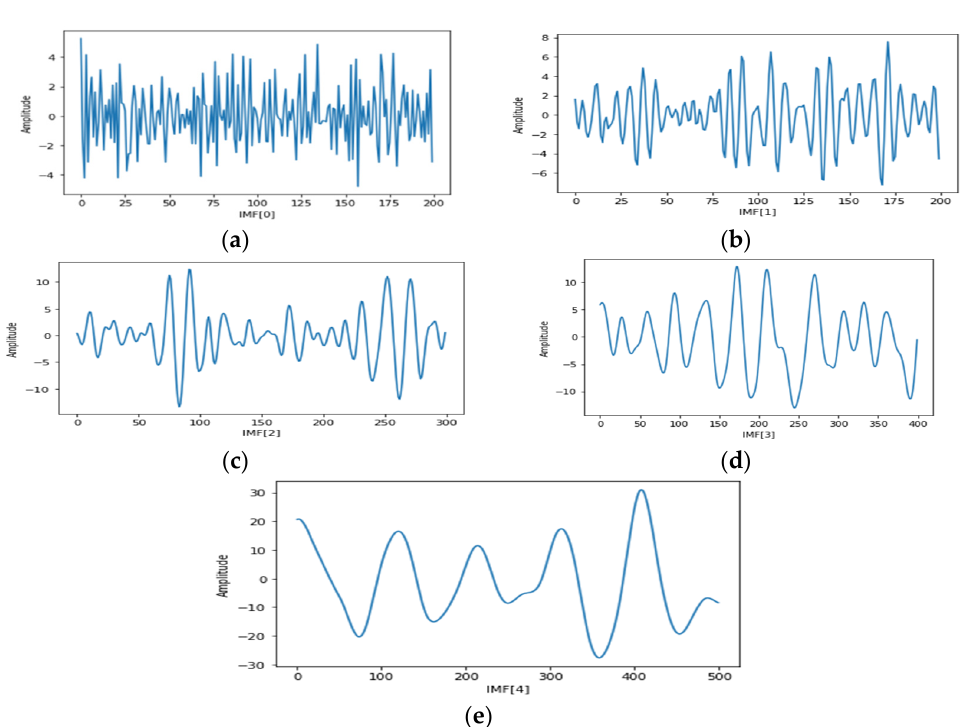
Figure 2. Shows five IMFs of EMD applied on chb01_01 of Dataset2. IMF0, IMF1, IMF2, IMF3 and IMF4 are shown in ( a – e ) accordingly.